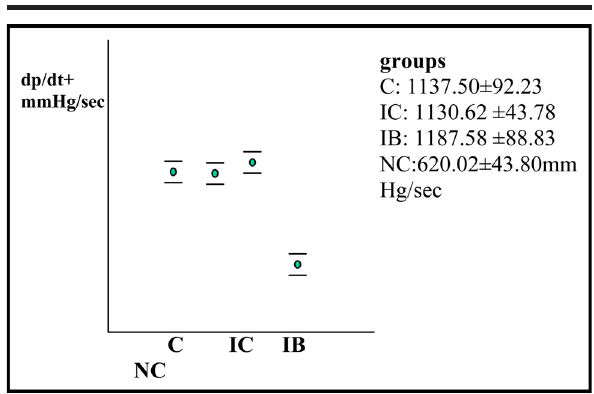
FIGURE 2 - Graphic representation of dp/dt+ (first derivative pressure in its positive deflection) and groups Ccontrol; IC-ischemic crystalloid; IB-ischemic Blood ; NCischemic non proteted.